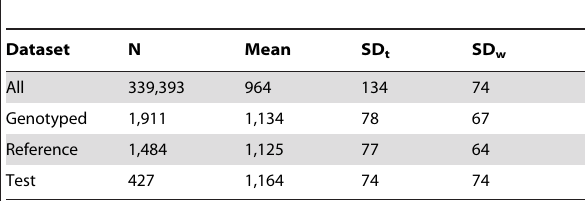
Table 1. Mean, total standard deviation (SD t ) and within-year standard deviation (SD w ) of the corrected phenotypic values of daily gain in different